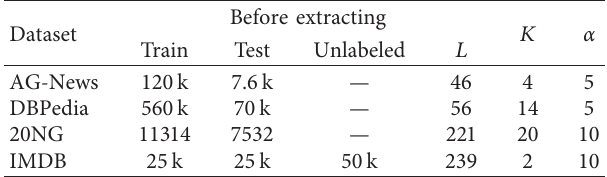
Table 3: Dataset